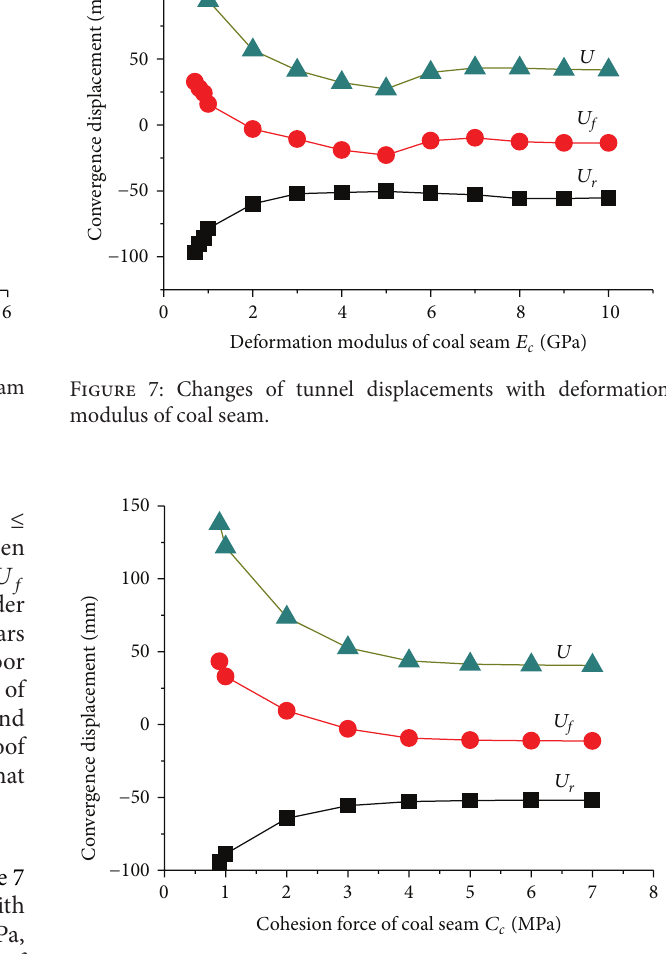
Figure 8: Changes of tunnel displacements with strength parame- ters of coal seam.